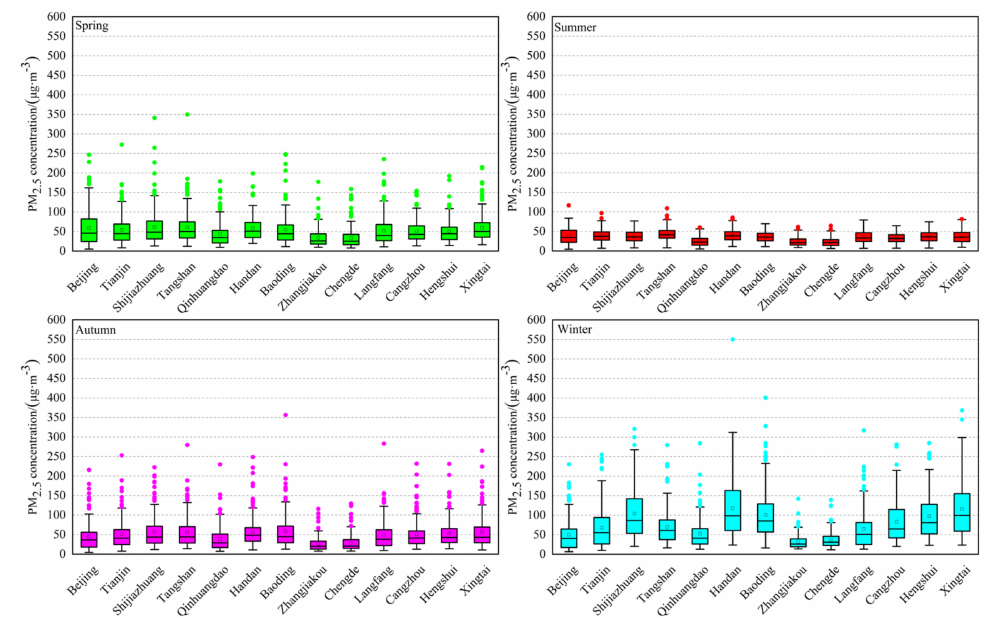
Figure 4. Box and whisker plots of seasonally averaged PM 2.5 concentrations in the Beijing-Tianjin- Hebei region over